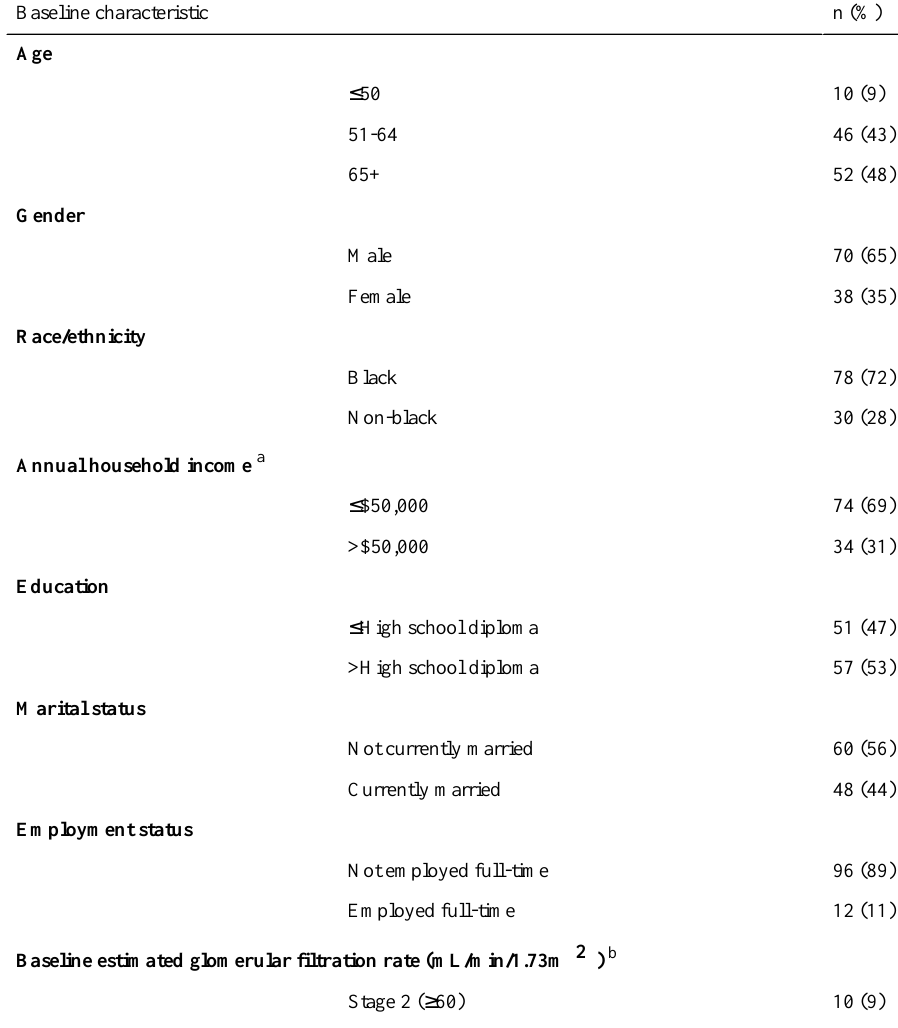
Table 1. Safe Kidney Care participants’baseline